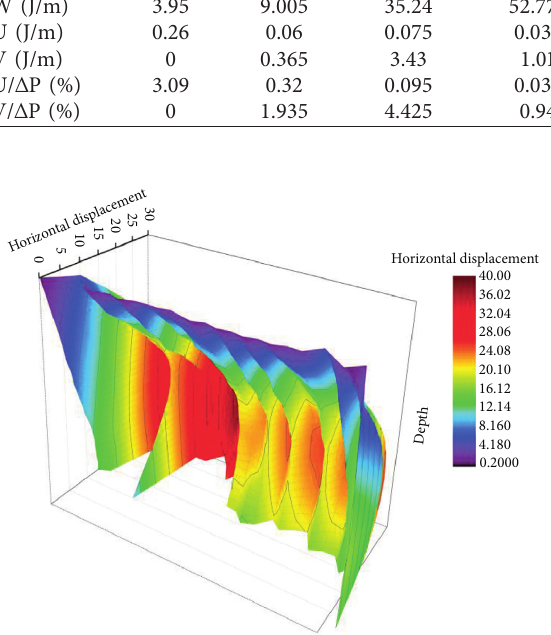
Figure 14: Horizontal displacement of the retaining wall.